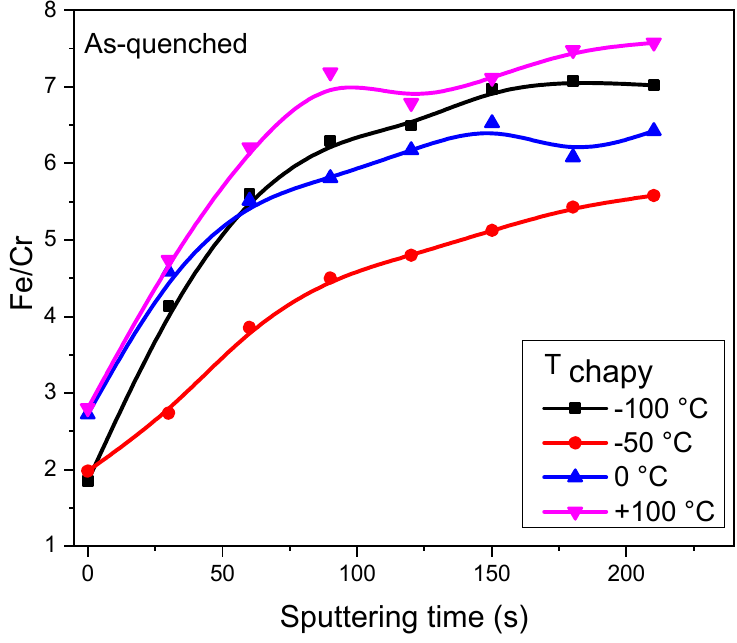
Figure 8. XPS depth profiles of Fe/Cr ratio for as-quenched probes broken in Charpy tests at different temperatures.